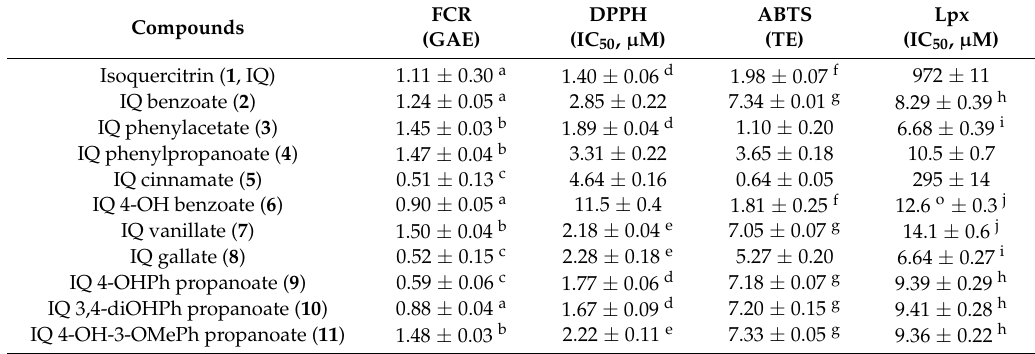
Table 1. Radical scavenging and anti-lipoperoxidant activity of isoquercitrin and its conjugates 2 – 11 . Compounds